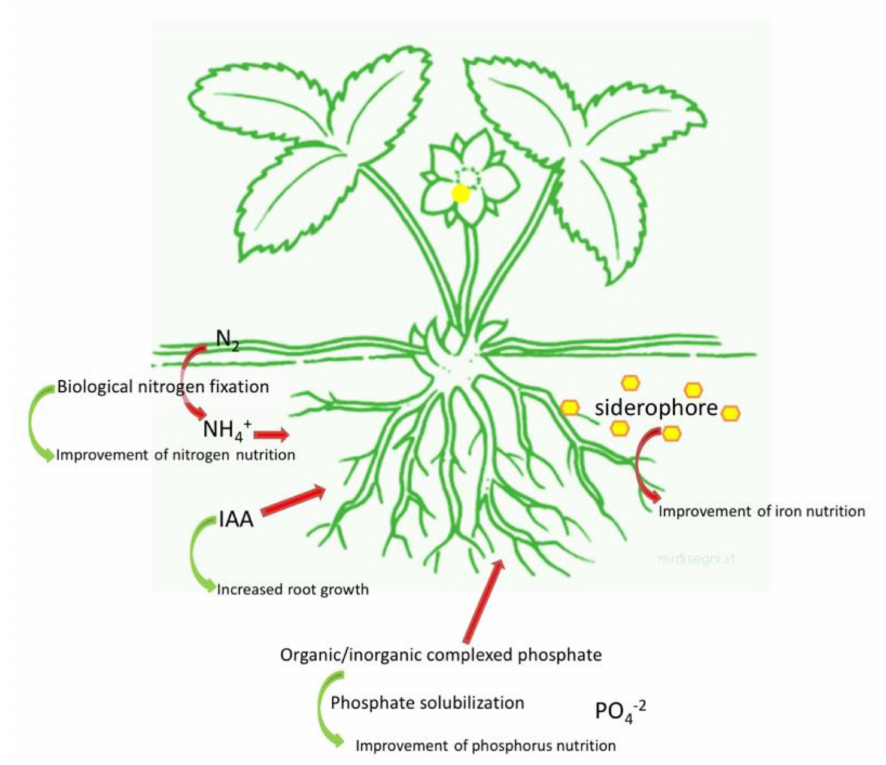
Figure 1. Overview of the main direct mechanisms used by PGPB. Improvement of mineral nutrition via nitrogen fixation, phosphate solubilization, and iron chelation, as well as the modulation of phytohormones